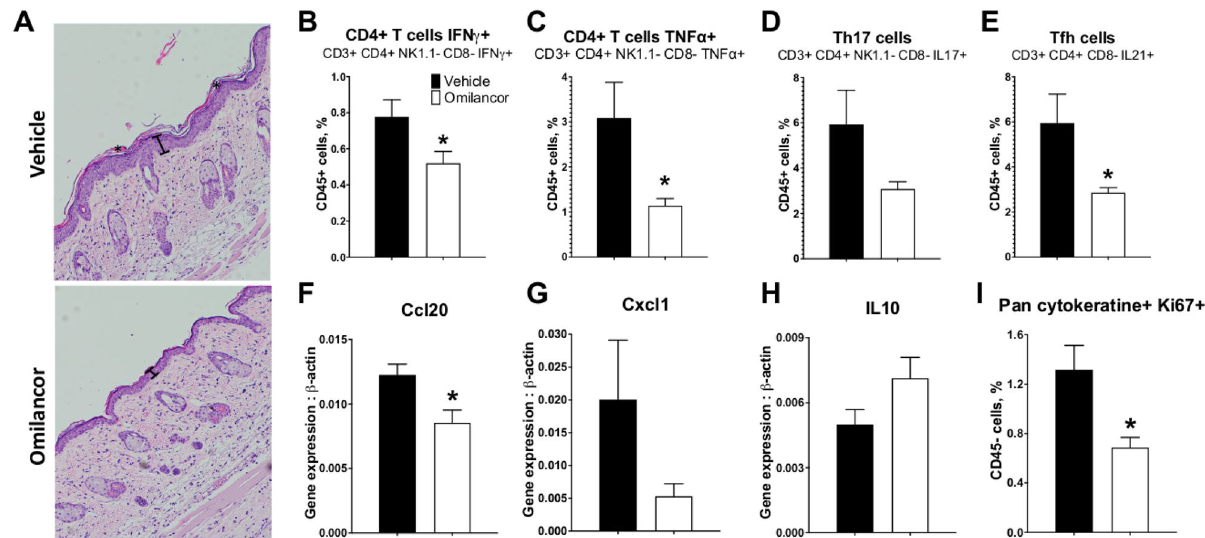
Figure 3. Therapeutic efficacy of topical omilancor treatment in IL-23-induced model of mouse PsO in dorsal skin. WT mice were shaved and daily challenged with intradermal injection of IL-23 at dorsal skin. Vehicle or omilancor formulations were administered daily 1 h post IL-23 injection. Mice were euthanized at day 4. Representative photomicrographs of H&E-stained dorsal skin at day 4 ( A ). Epidermal hyperplasia (|-|) and hyperkeratosis (*) are represented. Percentage of IFNγ+ CD4+ T cells ( B ), TNFα+ CD4+ T cells ( C ), Th17 cells ( D ) and Tfh cells ( E ) was quantified in draining ILNs through flow cytometry analysis. Ccl20 ( F ), Cxcl1 ( G ), and IL10 ( H ) expression from dorsal skin was measured by qRT-PCR. Percentage of Pan cytokeratine+ Ki67+ cells ( I ) was assessed through flow cytometry analysis. * P ≤